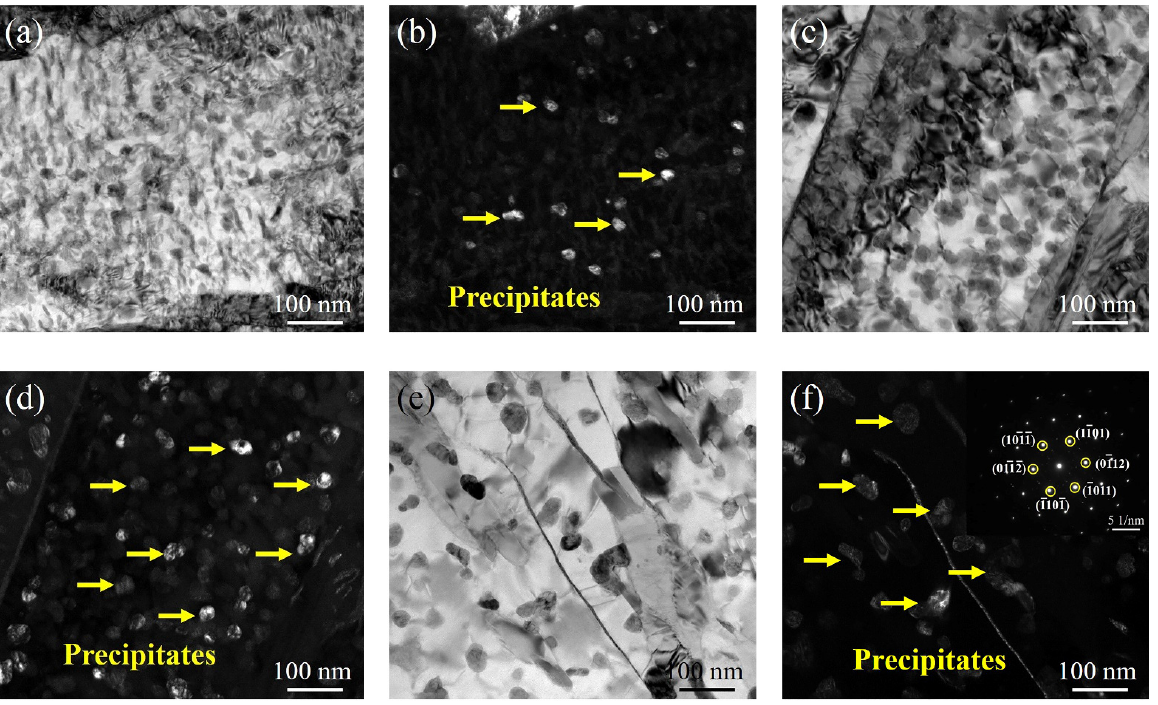
Figure 5. TEM morphology of the specimens under various thermal conditions: ( a ) bright-field im- age of 600A-0.5, ( b ) dark-field image of 600A-0.5, ( c ) bright-field image of 600A-4, ( d ) dark-field image of 600A-4, ( e ) bright-field image of 600A-80, ( f ) dark-field image of 600A-80 and the diffraction spot calibration results of the precipitates.